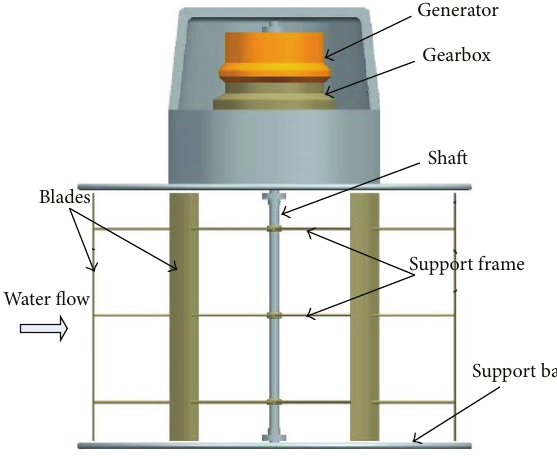
Figure 1: VAT water energy conversion system.